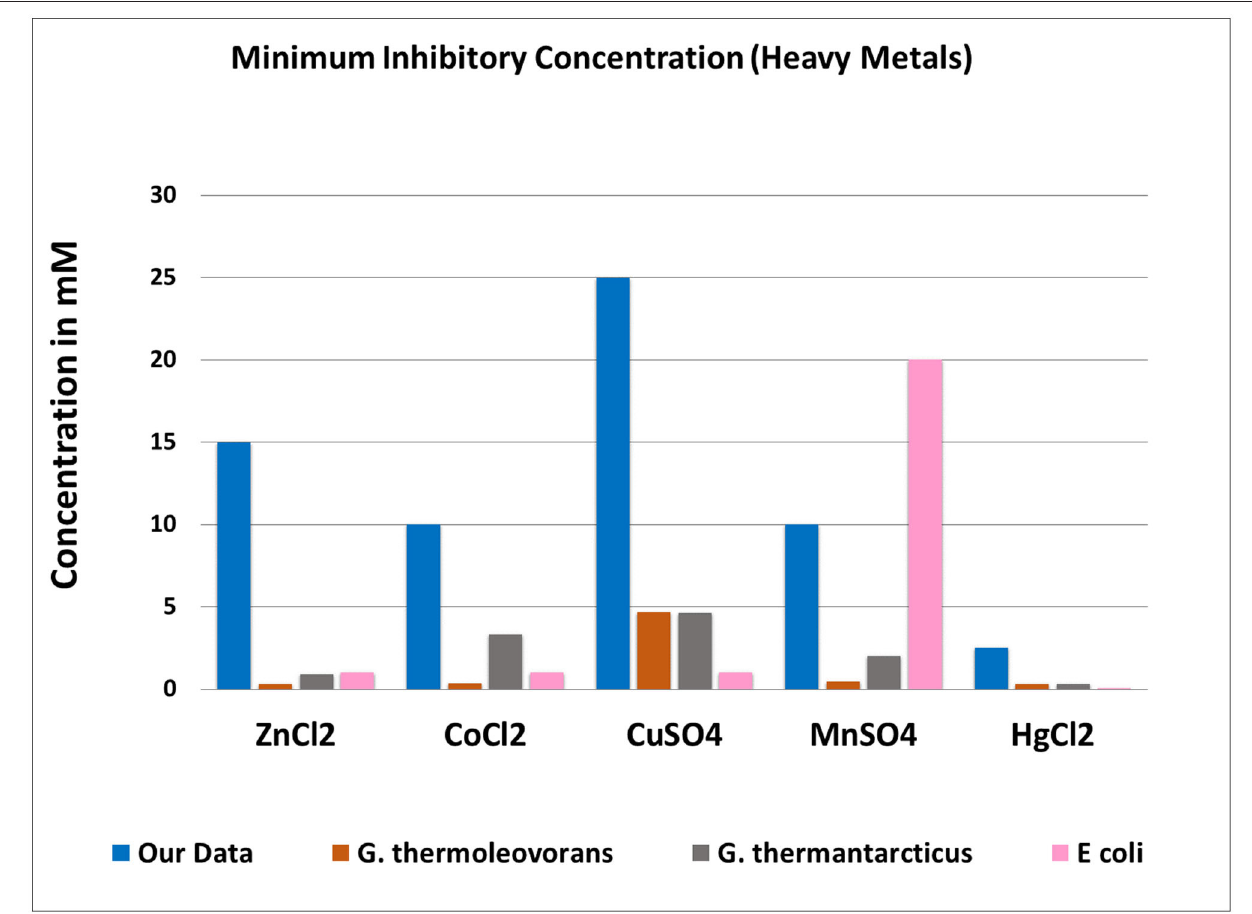
FIGURE 5 | Comparison of minimum inhibitory concentrations among studied isolates and two known Geobacillus s pecies and an E. coli